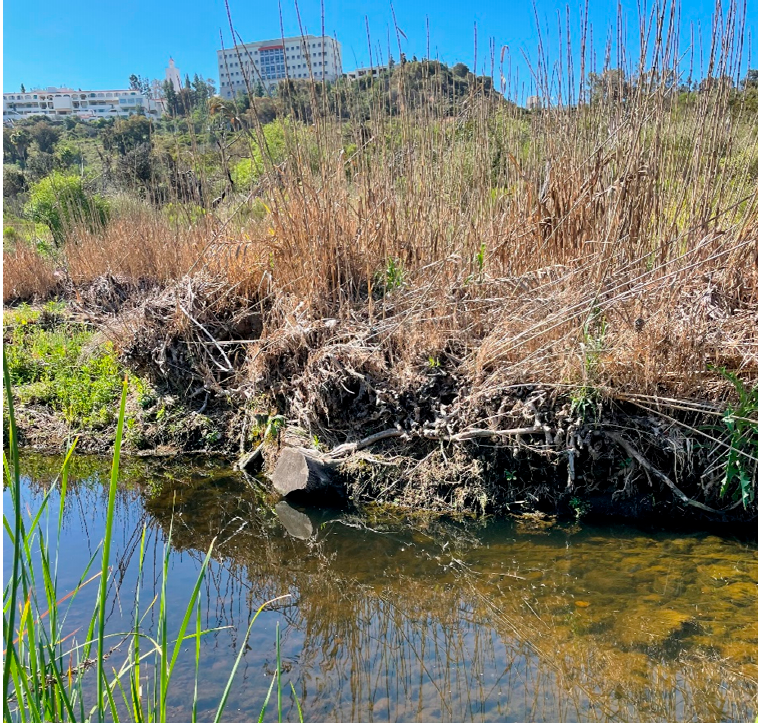
Figure 5. Bank failure within the upstream reach of Del Cerro, Alvarado Creek.